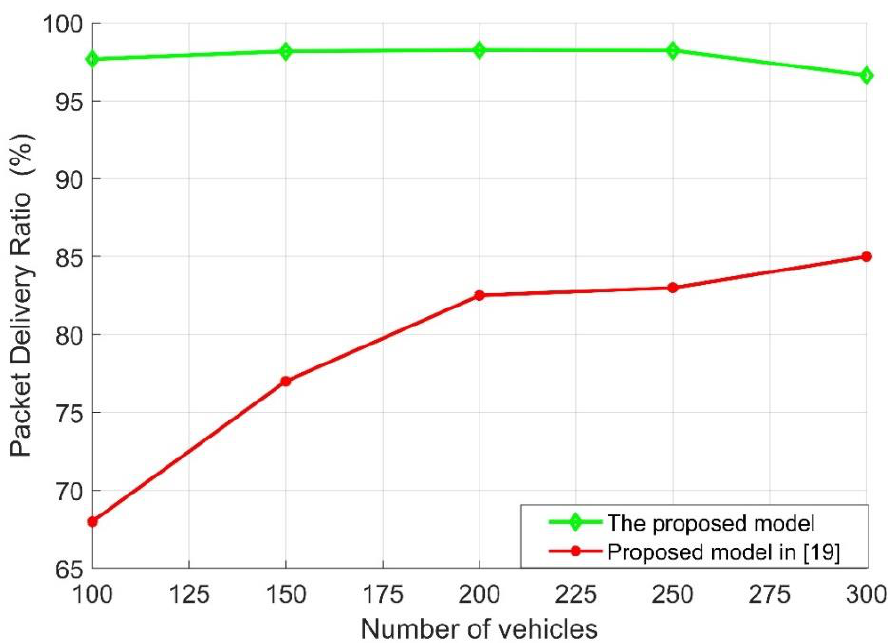
Figure 5. Packet delivery ratio [PDR] vs. number of vehicles.